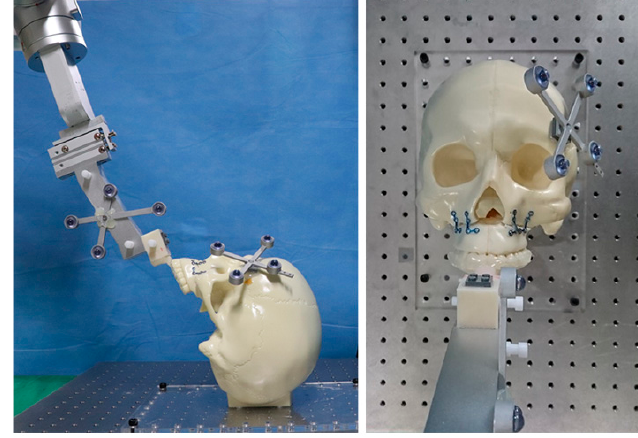
Figure 5. Stabilization of the repositioned maxillary segment.